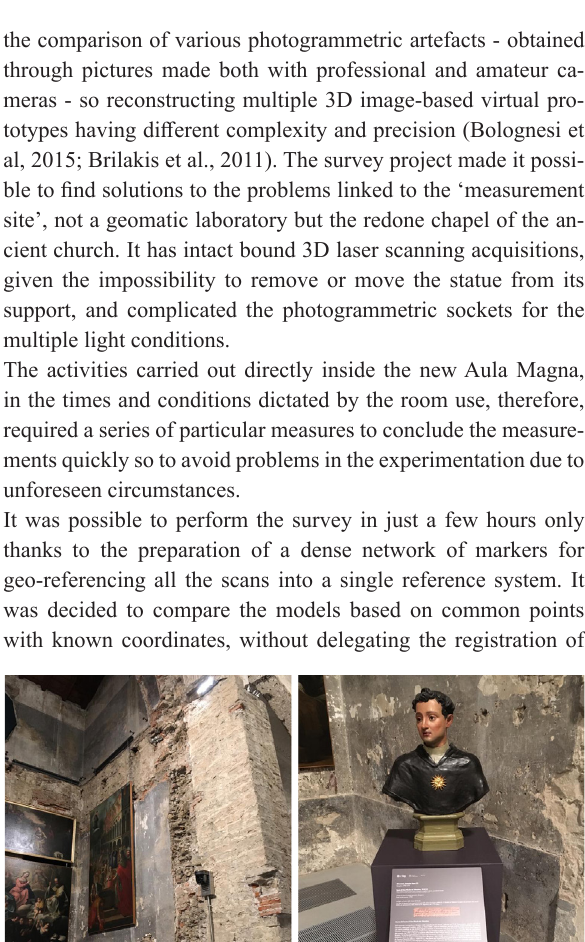
Figure 1. The former church of Sant’Agostino in Bergamo, today the Aula Magna of the University of Bergamo